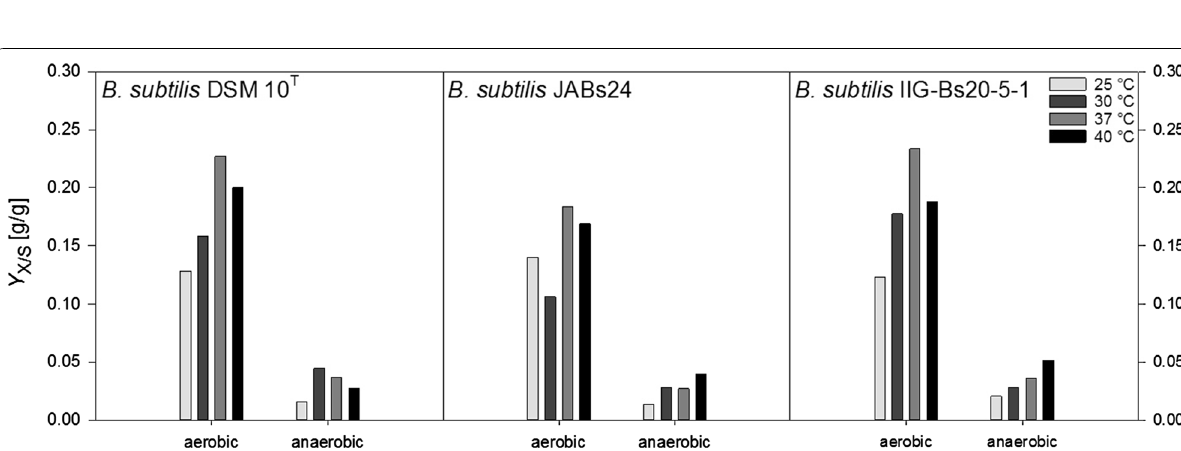
Fig. 3 Overview of the calculated biomass yields on substrate Y X/S (g/g) for strains B. subtilis DSM 10 T , B. subtilis JABs24 and B. subtilis IIG-Bs20-5-1 under aerobic and anaerobic conditions at 25 °C, 30 °C, 37 °C and 40